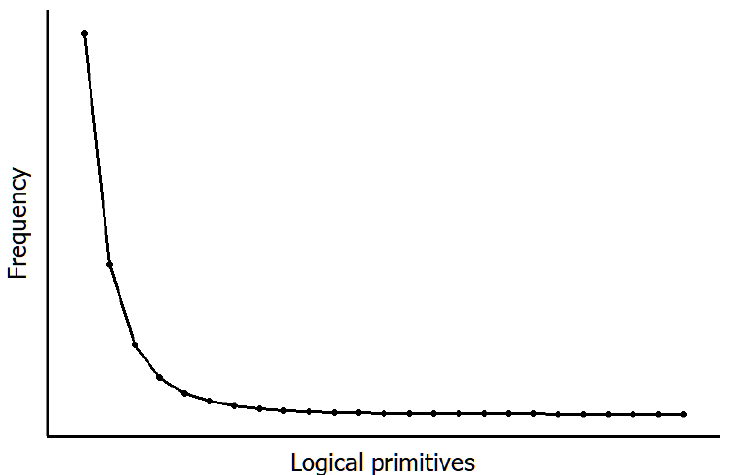
Figure 1. A long-tail distribution of logical primitives. This distribution shows the hypothesis that a few of the logical primitives are frequently used in cognition, but the vast majority are rarely used. This hypothesis is consistent with the emergence of new abilities in large language models [41].